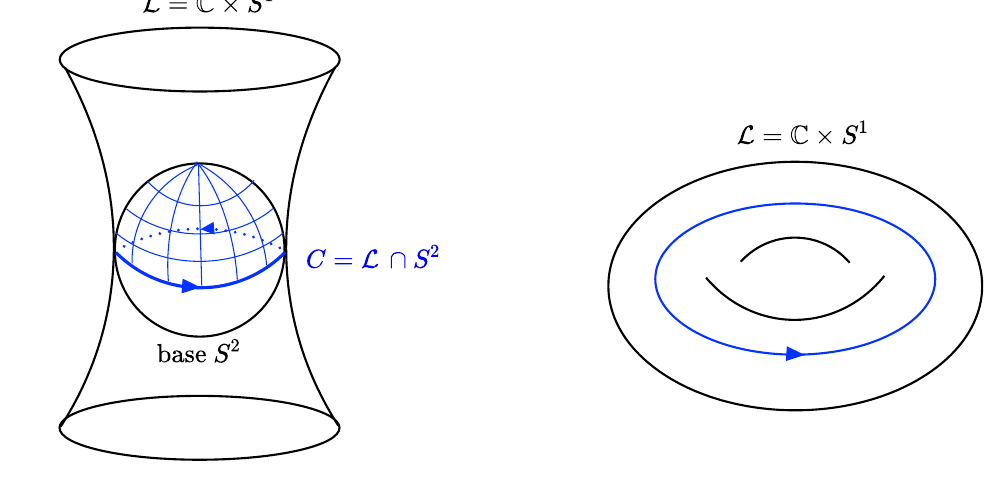
Figure 5 . The left figure shows worldsheet instantons ending on D-branes which cut the minimal volume S 2 of the resolved conifold along the equator. The branes extend into the non compact fiber directions and wrap a Lagrangian submanifold with the topology C × S 1